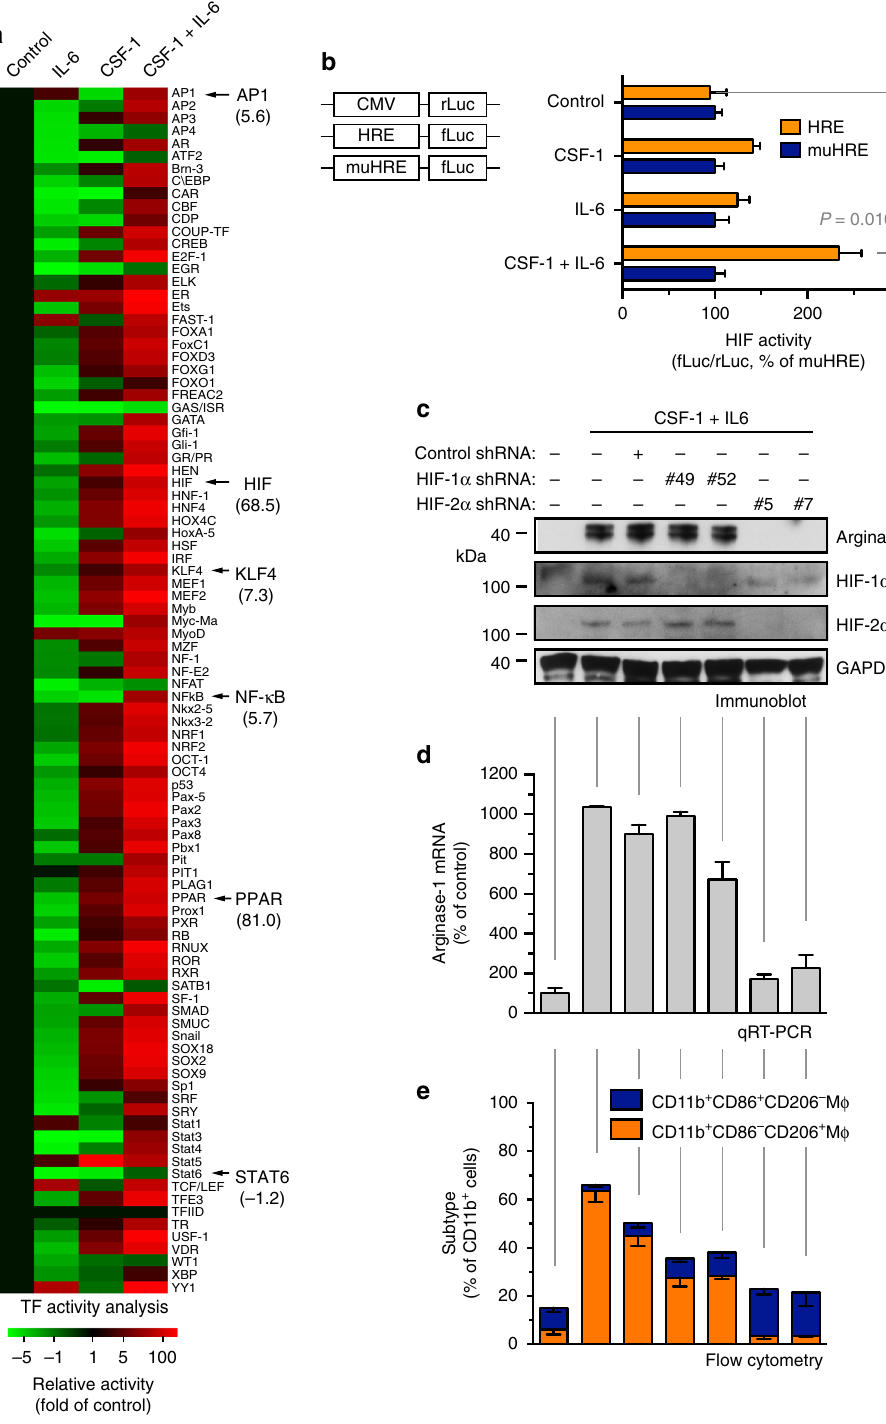
Fig. 5 HIF-2 α is critical for IL-6-mediated arginase-1 expression and alternative macrophage activation. a Mouse BM-derived macrophages were treated with CSF-1 and IL-6 for 3 days. Nuclei proteins were subjected to multiplex pro fi ling analysis for transcriptional factor activation. Activity was normalized with transcription factor IID, and expressed as the folds of control. b Mouse BM-derived macrophages were transduced with lentivirus that expresses CMV promoter-driven renilla luciferase (CMV-rLuc), hypoxia response element-driven fi re fl y luciferase (HRE-fLuc), and mutated HRE-fLuc (muHRE-fLuc), followed by treatment with CSF-1 and IL-6 for 2 days. Reporter activity radio of fLuc versus rLuc was determined by bioluminescence. Results were expressed as the percentage of muHRE ( n = 3, mean ± SEM). P value was determined by Student ’ s t test. c – e Mouse BM-derived macrophages were transduced with lentivirus that expresses shRNAs targeting control scrambled sequence, HIF-1 α (#49 and #52) and HIF-2 α (#5 and #7), followed by treatment with CSF-1 and IL-6 for 10 days. c Cells were lysed and subjected to immunoblot analysis. d Arginase-1 mRNA was analyzed by real-time RT- PCR. Shown are quanti fi ed data (normalized with GAPDH expression, n = 3, mean ± SEM). e Cells were stained with anti-CD11b, anti-CD86, and anti- CD206 antibodies, followed by fl ow cytometry analysis ( n = 3, mean ±